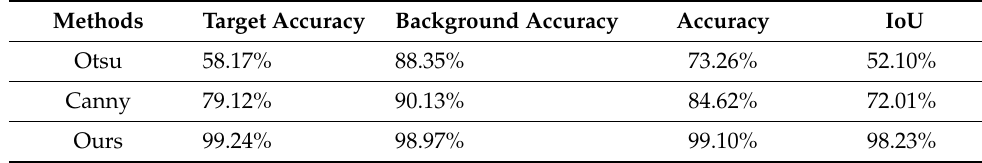
Table 8. Segmentation performance (%) of different